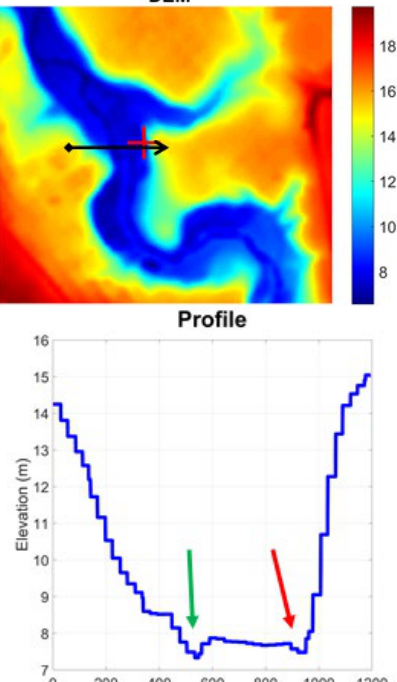
Figure 10: A profile through the DEM for the section indicated by the black arrow is presented in the top figure. In the profile on the bottom: the red and green arrows indicate the old and the current locations respectively of the Canning river.